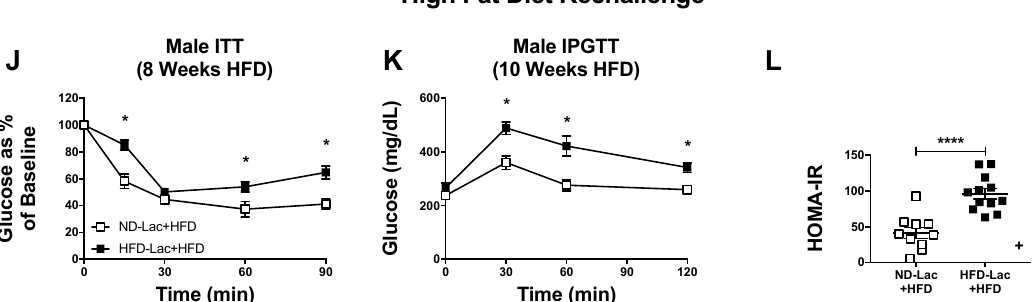
Figure 1. Male lactation high-fat diet (HFD) o ff spring show insulin resistance and mild glucose intolerance on a normal diet. Analyzed experimental groups: ND-Lac (white circles), HFD-Lac (black circles), ND-Lac + HFD (white squares), HFD-Lac + HFD (black squares). Weekly weights of dams during the lactation period starting on postnatal day 7 ( A ). Weekly weights of male and female o ff spring during the lactation period ( B ). Weekly weights of male o ff spring throughout adulthood, arrow indicates the start of HFD re-challenge ( C ). Data collected from males maintained on a normal diet ( D – I ). Insulin tolerance tests (ITT) at 10 weeks of age, 6 h fast, 0.75 U / kg insulin, ND-Lac n = 7, HFD-Lac n = 10 ( D ). Intraperitoneal glucose tolerance tests (IPGTT) at eight weeks of age, 6 h fast, 2 g / kg dextrose, ND-Lac n = 8, HFD-Lac n = 13 ( E ). HOMA-IR at eight weeks of age measured after 6 h fast ( F ). ITT at 20 weeks of age, ND-Lac n = 5, HFD-Lac n = 12 ( G ). IPGTT at 22 weeks of age, ND-Lac n = 4, HFD-Lac n = 7 ( H ). HOMA-IR at 23 weeks of age ( I ). Data collected from males re-challenged with HFD at 12 weeks of age ( + HFD) ( J – L ). ITT after eight weeks of HFD feeding, 1 U / kg, ND-Lac + HFD n = 10, HFD-Lac + HFD n = 11 ( J ). IPGTT after 10 weeks of HFD feeding, 0.66 g / kg dextrose, ND-Lac + HFD n = 8, HFD-Lac + HFD n = 6 ( K ). HOMA-IR after 11 weeks of HFD feeding ( L ). * p < 0.05, *** p < 0.001, **** p < 0.0001. + indicates a significant interaction between lactation exposure and HFD